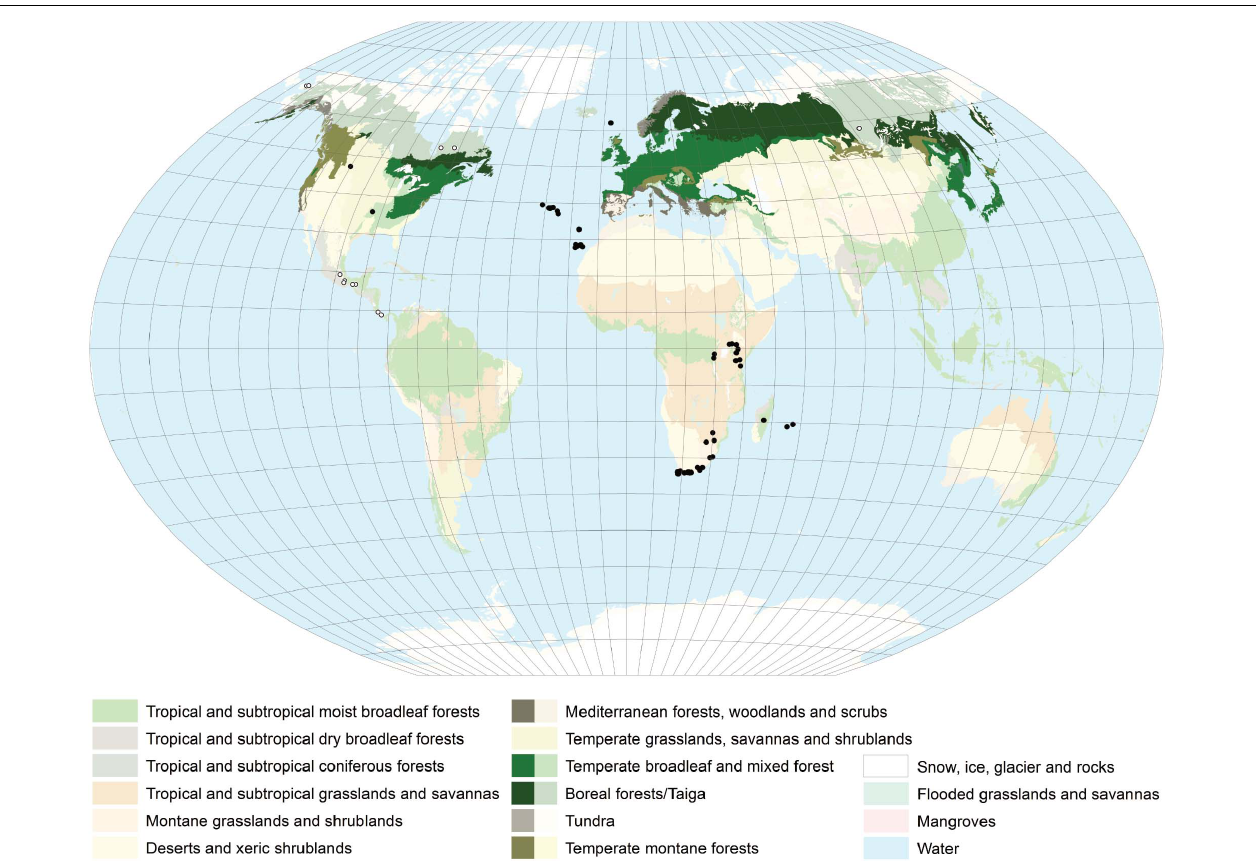
FIGURE 3 | Distribution map of L. pulmonaria created with ArcGIS 10. Colors indicate the different vegetation zones. Strongly colored areas – general distribution regions. Solid dots – single occurrence spots. Open dots – occurrence not clarified. L. pulmonaria has a worldwide distribution mainly occurring in the Northern